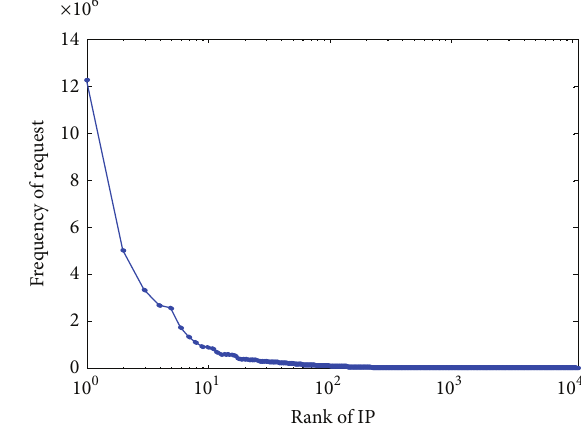
Figure 1: Frequency of request versus IP rank.